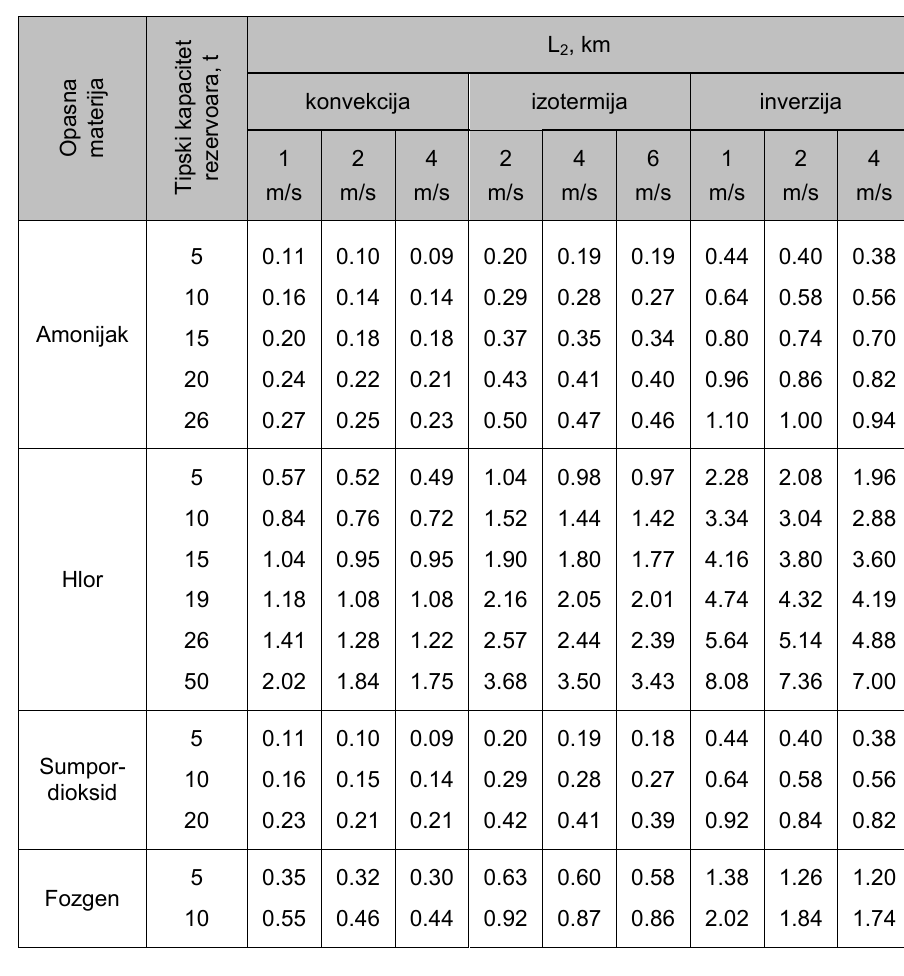
Table 2 – Depth of spreading the dangerous zone of secondary vapor clouds (L1) at a spill of hazardous materials into a protective pool, depending on the type and weight of hazardous materials, vertical stability of the air and the wind